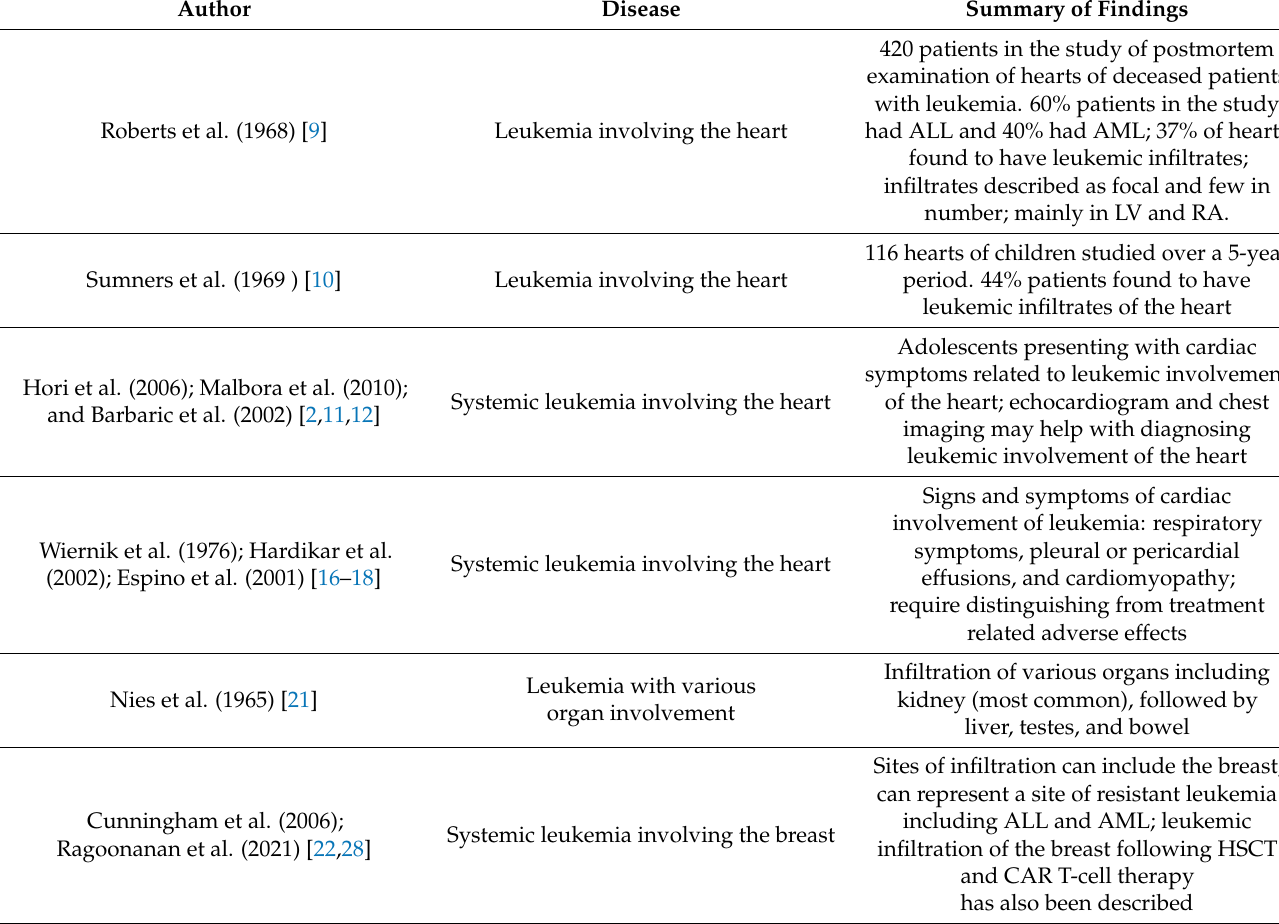
Table 3. Literature describing leukemic infiltration of various